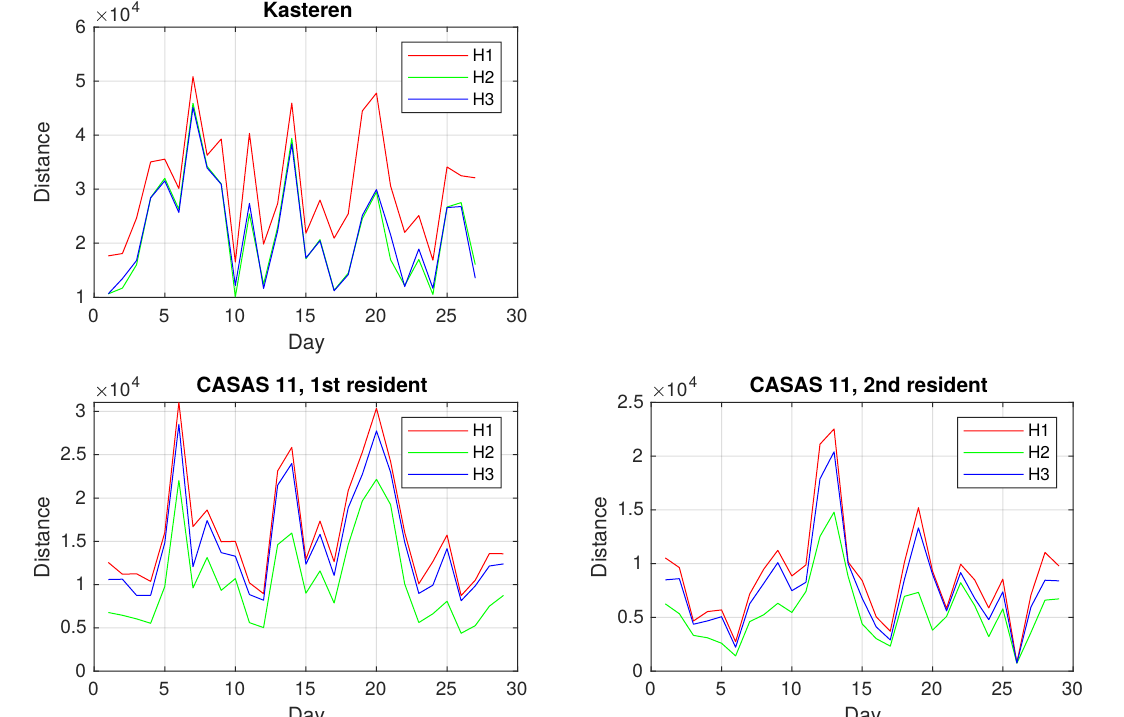
Figure 5. Hamming distances between daily activity vectors for consecutive days for the Kasteren dataset, the first resident of the CASAS 11 dataset, and the second resident of the CASAS dataset.